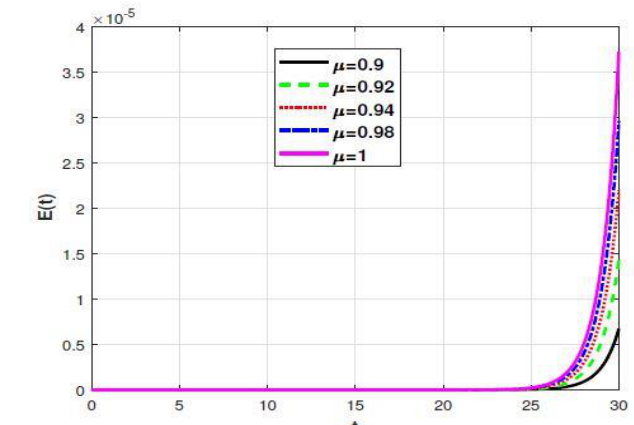
Fig. 8. Numerical experiments of death class for various value of fractional order 𝝁